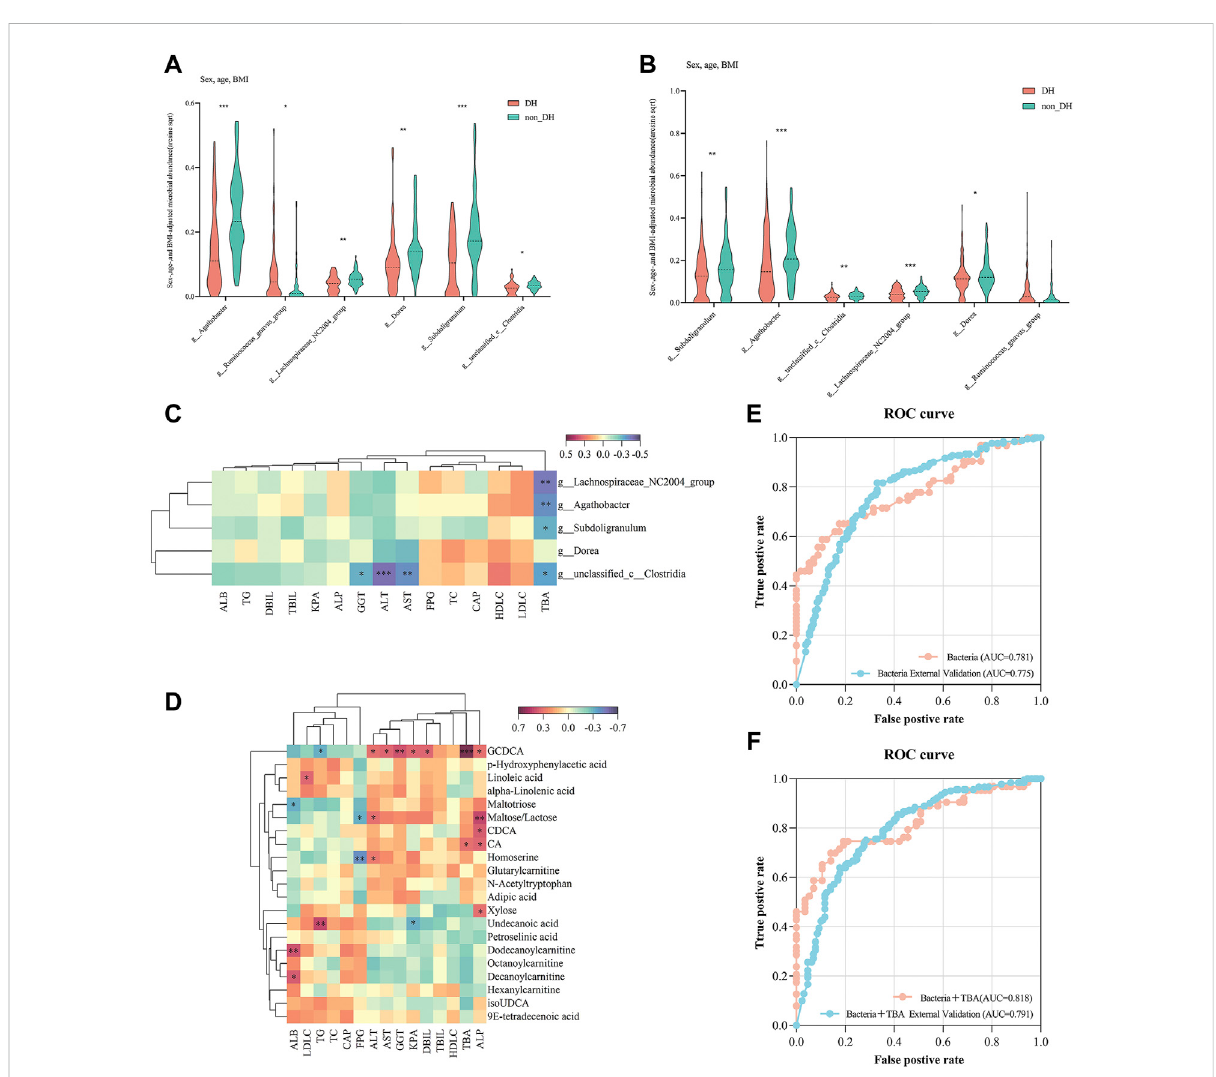
FIGURE 5 Fivegenera havediagnosticpotential forDHsyndrome.Relativeexpressionofsixbacterialgenerain (A) 146individualswithandwithouttypical DHsyndromeand (B) allchronicliverdiseaseindividualswithandwithoutDHsyndromeadjustedforage,sex,andBMI; (C) CorrelationanalysisofDH syndrome-associated gut genera and clinical indices; (D) correlation analysis of DH syndrome co-altered trends metabolites and clinical indices; ROC curves wereplotted for thediagnosisof DHsyndrome in10-fold cross-validationand testsetvalidation (310patients withCHB orNAFLD) using the combination of (E) fi ve genera, and (F) fi ve genera combined with serum TBA. The areas under the ROC curves (AUCs) were